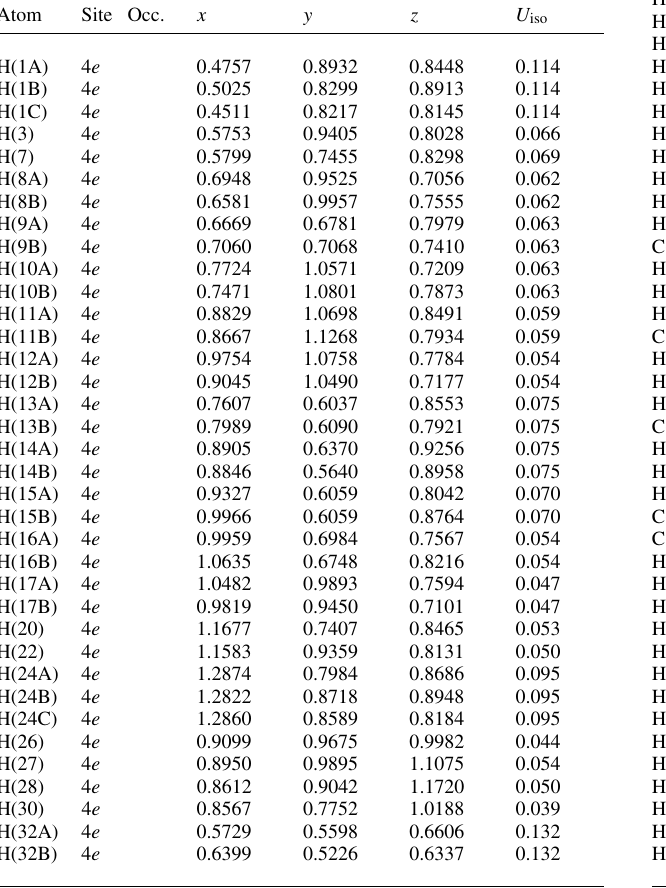
Table 2. Atomic coordinates and displacement parameters (in Å 2 ) .